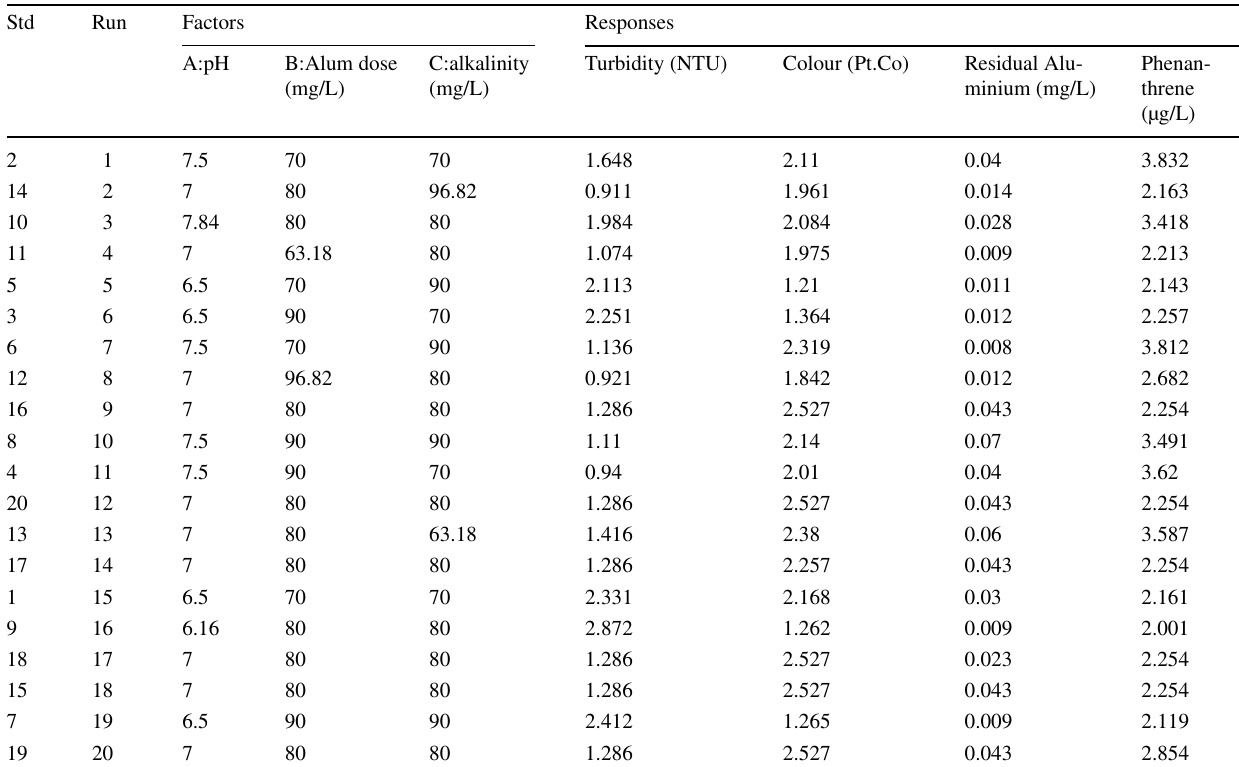
Table 4 Full factorial experimental design and responses for the experimental variables